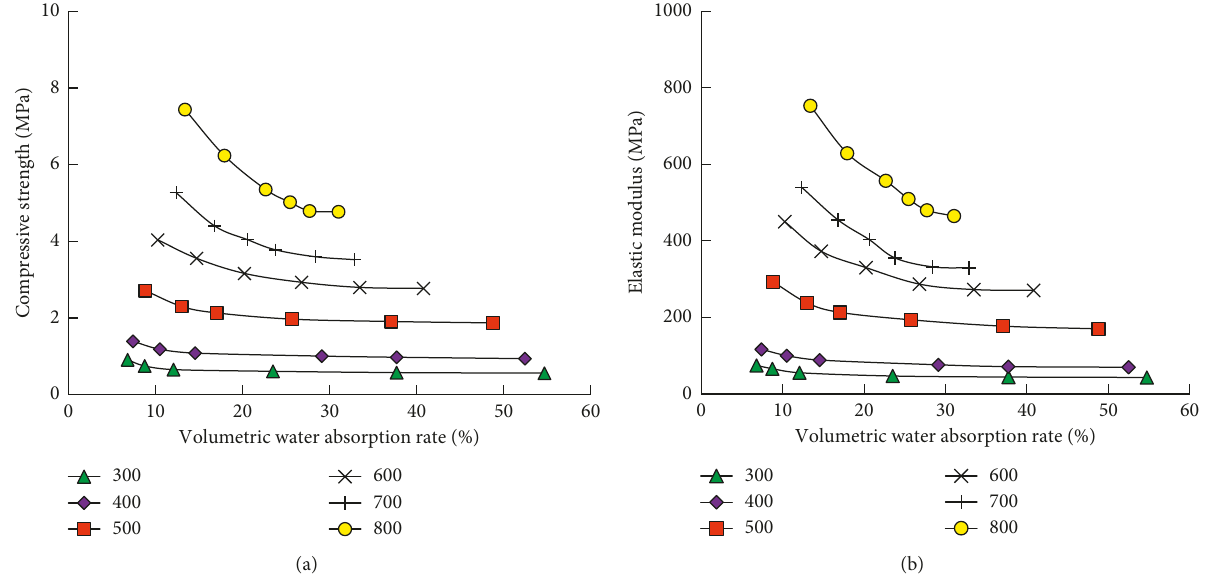
Figure 10: Effect of volumetric moisture content on (a) compressive strength and (b) elastic modulus.